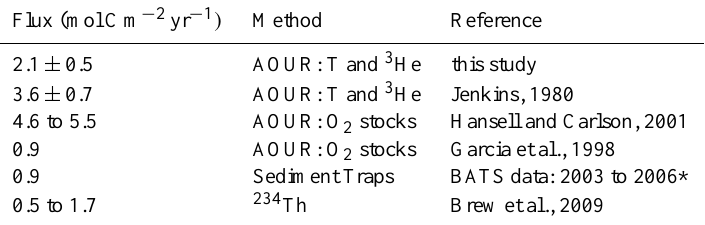
Table 1. Estimates of export flux from this and other studies.